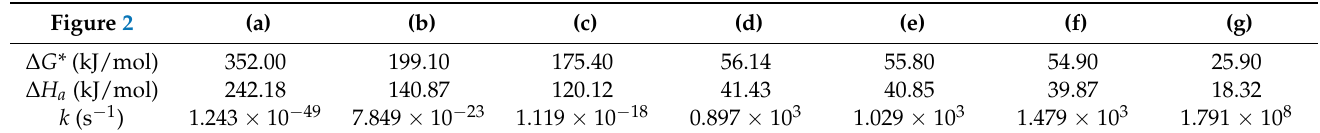
Table 1. Activation energy ( ∆ G* ) and enthalpy ( ∆ Ha ) computations of light gray Ca dissolution on the facets of 001 or 001 for seven different scenarios at the room temperature (298 K) as shown in Figure 2 by molecular dynamics and density functional theory (DFT) simulation methods, respectively. Rate constants of light gray Ca dissolution computed according to the activation energies obtained through molecular dynamic simulation method at the room temperature.